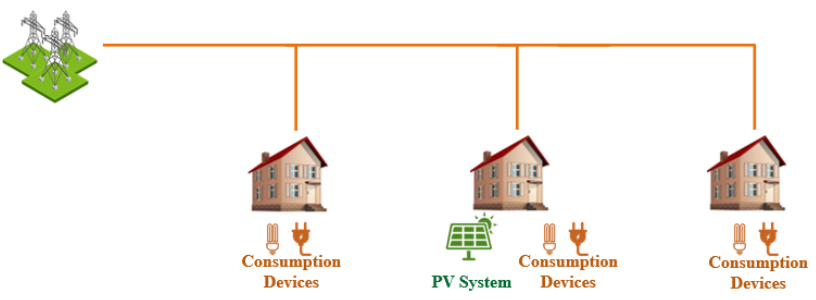
Figure 10. EnC system studied.